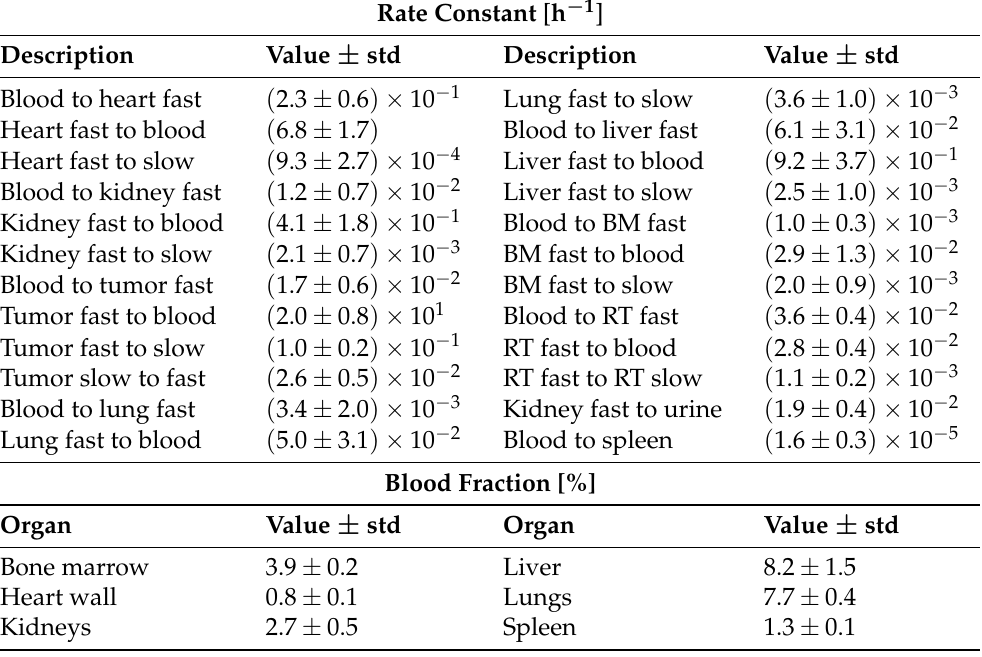
Table 3. Best-fitting parameter values and Monte Carlo calculated standard deviations obtained from 100 runs of the optimization algorithm with a dataset stochastically sampled from the experimental points and uncertainties.